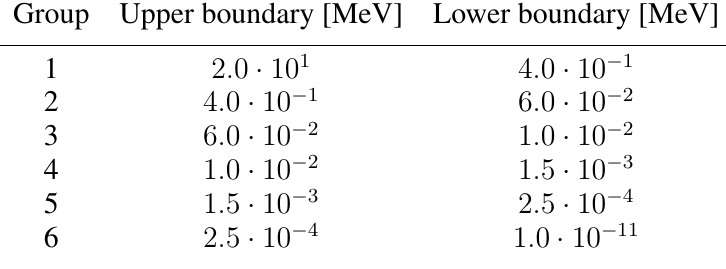
Table 2: Six-group data adopted to perform the macroscopic cross sections energy